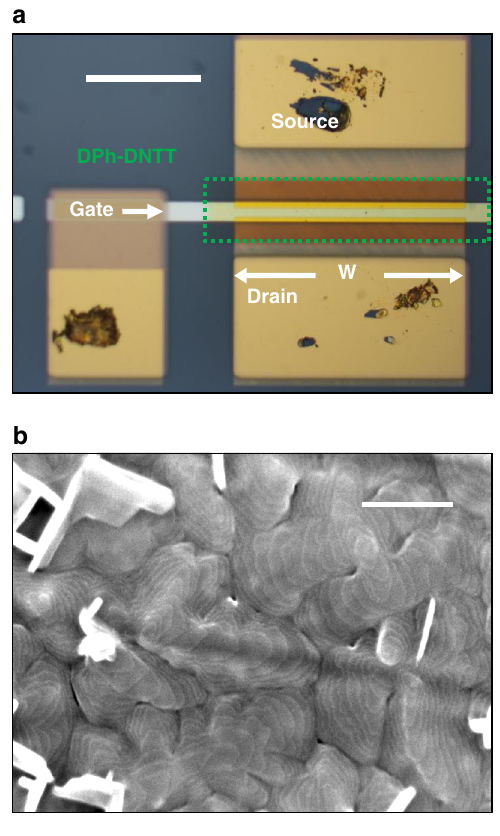
Fig. 4 DPh-DNTT TFTs fabricated on fl exible PEN substrates. a Optical microscopy image of a bottom-contact TFT with a channel length of 8 µ m, a total gate-to-contact overlap (sum of the gate-to-source and gate-to-drain overlaps) of 10 µ m, and a channel width of 200 µ m on a fl exible PEN substrate. The scale bar corresponds to 100 µ m. b SEM image of the DPh- DNTT fi lm in the channel region of a bottom-contact TFT on the